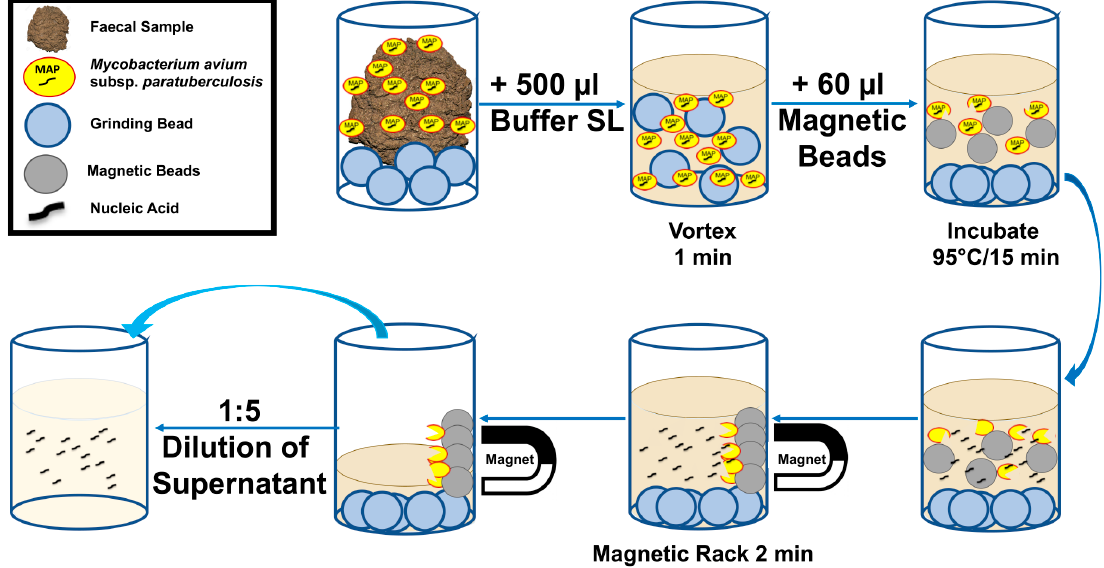
Figure 1. Workflow of the rapid point of need Mycobacterium avium subspecies paratuberculosis (MAP) extraction protocol. The procedure combines bead beating together with the basic SpeedXtract method. It represents protocol number 10 in Table 1.